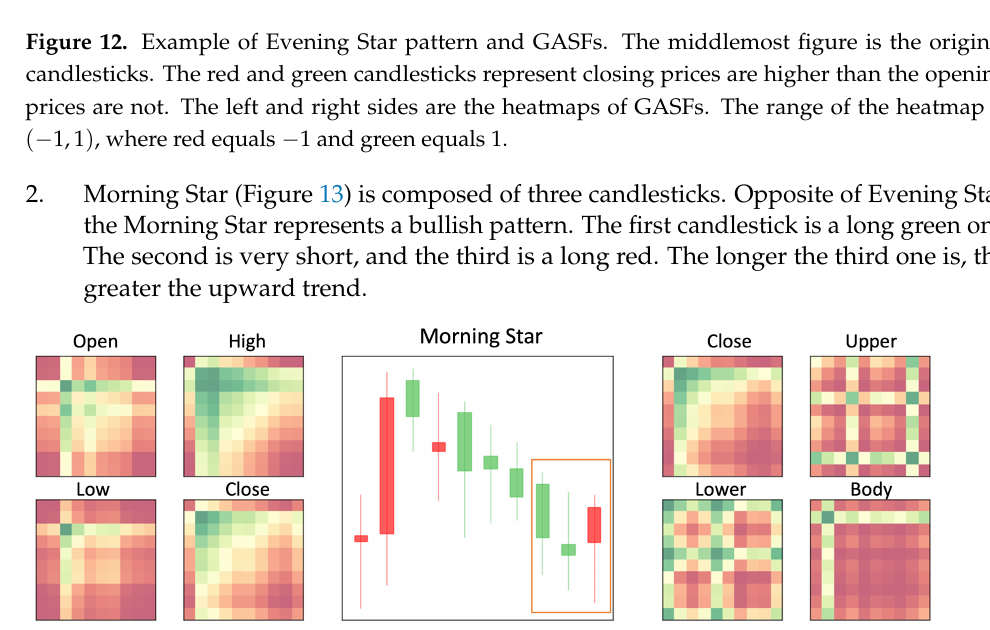
Figure 13. Example of Morning Star pattern and GASFs. The middlemost figure is the original candlesticks. The red and green candlesticks represent closing prices are higher than the opening prices are not. The left and right sides are the heatmaps of GASFs. The range of the heatmap is ( − 1,1 ) , where red equals − 1 and green equals